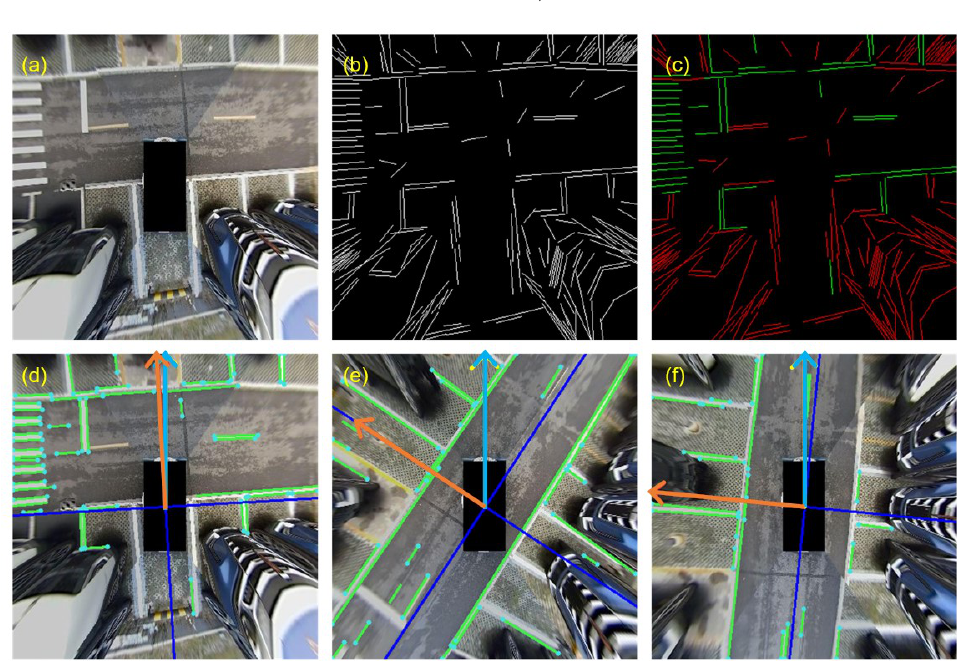
Figure 4. The three subfigures in the upper row illustrate the procedure of structure information extraction: ( a ) denotes the raw input synthesized image, ( b ) the extracted raw lines, and ( c ) the segmentation results, in which green lines denote the preserved marking lines and red lines denote the noisy lines. ( d – f ) denote the relationship between the local dominant direction and global orientation, in which the orange arrow denotes the local dominant direction and the blue arrow denotes the global dominant direction for the current frame, respectively, while the green lines denote the marking